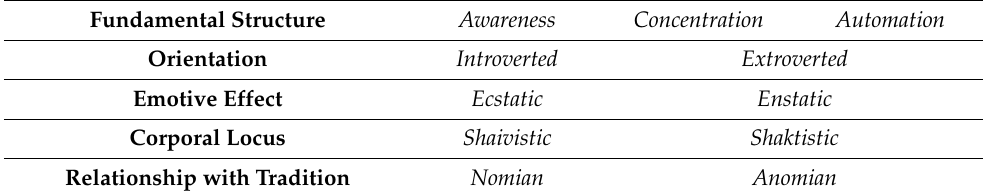
Table 1. Typology of Meditative Phenomena. Fundamental Structure Awareness Concentration Automation Orientation Introverted Extroverted Emotive Effect Ecstatic Enstatic Corporal Locus Shaivistic Shaktistic Relationship with Tradition Nomian